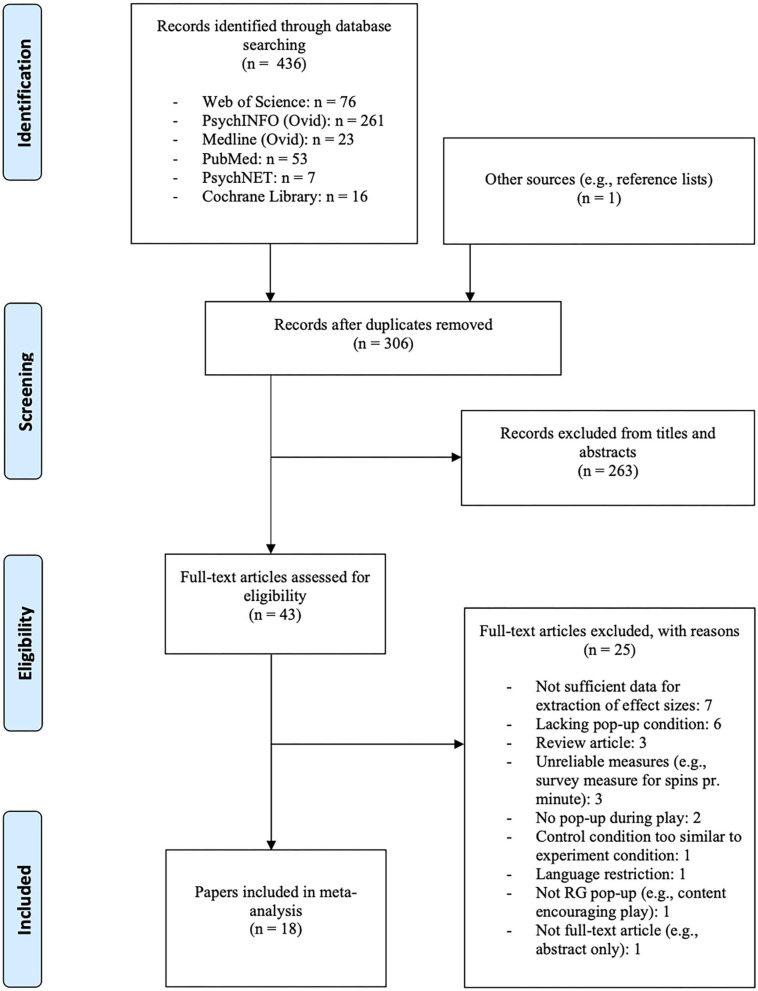
PRISMA flow chart.